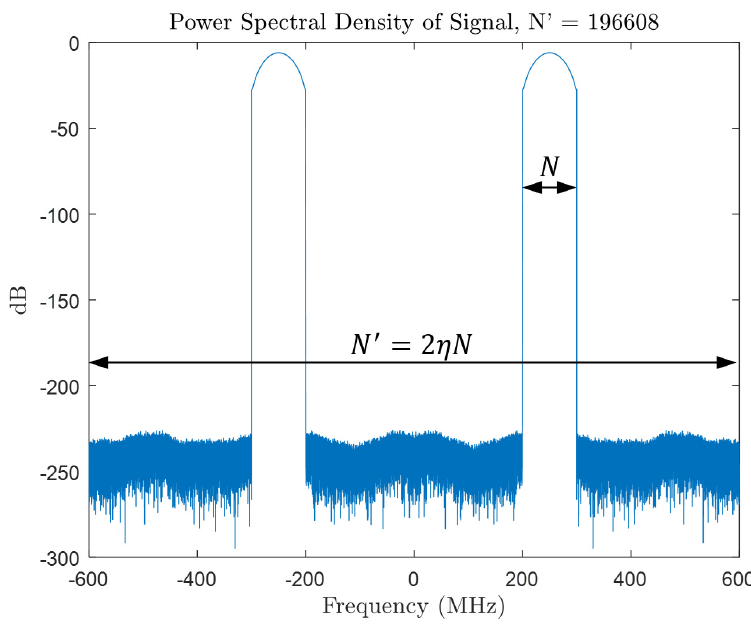
Figure 11. Power spectrum of IF band COSPAR signal (200–300MHz).